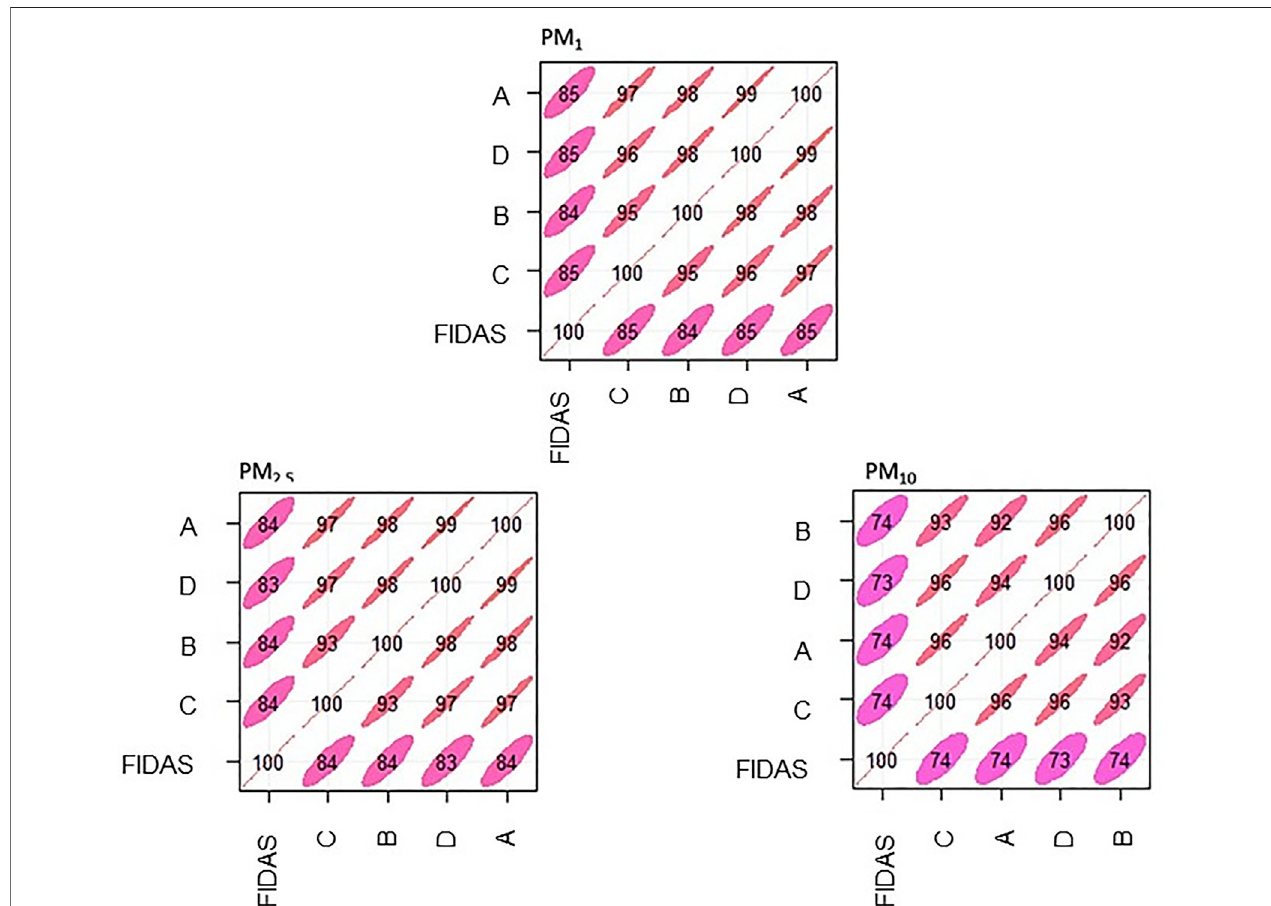
FIGURE 3 | Correlation plot demonstrating inter-sensor correlation and correlation to reference instrumentation.